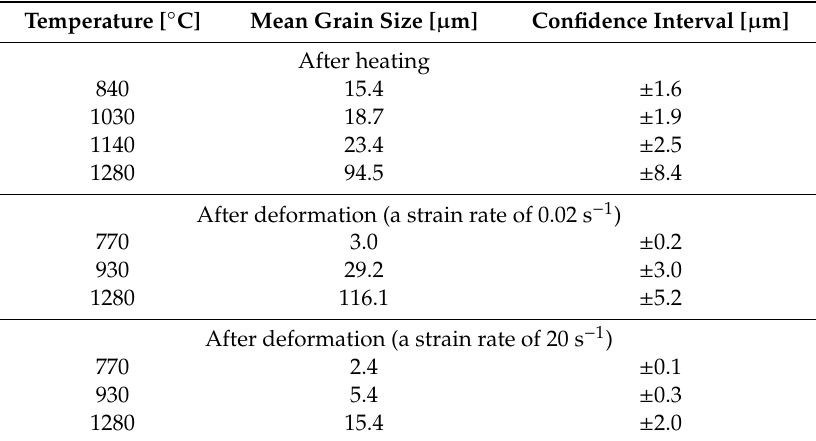
Table 3. Prior austenitic grain size after heating or hot